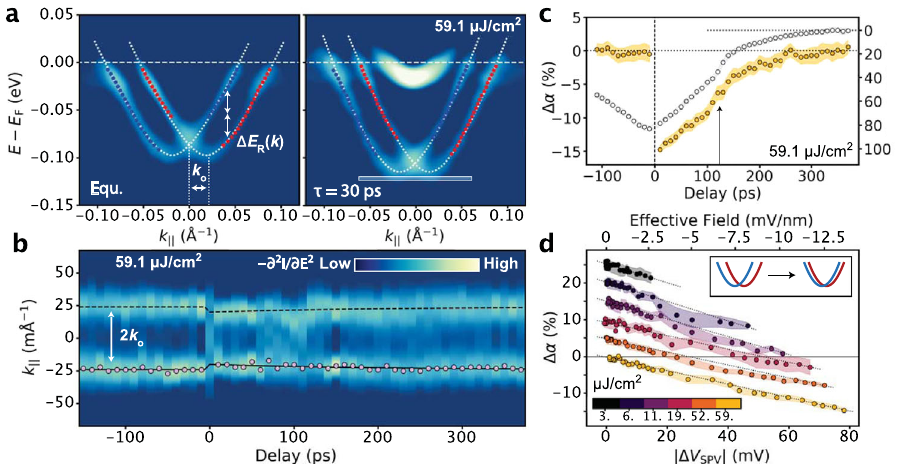
Fig. 4 Ultrafast- fi eld effect on Rashba splitting. a ∂ 2 / ∂ E 2 non-symmetrized spectra of quantum well states at equilibrium and 30 ps. Red and blue dots correspond to respective spin-split Rashba band positions for QW1. b ∂ 2 / ∂ E 2 non-symmetrized spectra integrated 15 meV below QW1 band bottom as a function of delay. Pink dots indicate peak positions on the negative- k band bottom, black lines represent 15% reduction in k 0 after pump that relax to equilibrium. c Percent change of the Rashba parameter (yellow) as a function of delay compared to the delay-dependent SPV (black open dots) at 59.1 μ J cm − 2 . After pump excitation, Rashba parameter drops by 15% and experiences a linear onset to exponential recovery (vertical arrow). d Percent change of the Rashba parameter versus SPV (and extrapolated effective fi eld) over a large fl uence range. Each fl uence measurement is spaced by 5% for visibility. Shaded outlines in c and d represent error propagated from covariance in fi ts from a